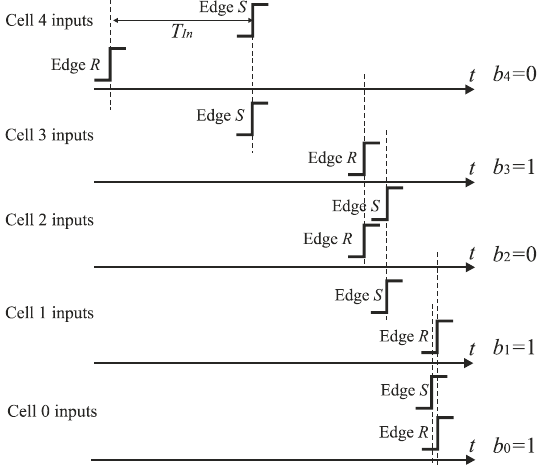
Figure 11. Time diagram of time-to-digital conversion for 5-bit SA-TDC.